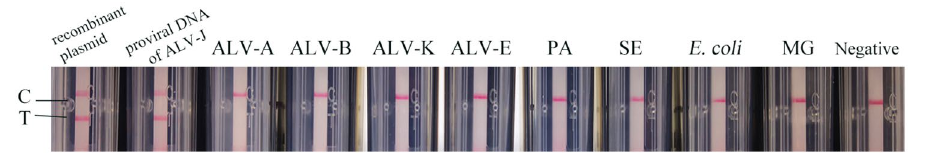
Figure 9. Analysis of the specificity of the ALV-J CPA method. PA Pseudomonas aeruginosa, SE Salmonella enteritis , MG Mycoplasma gallisepticum , C control-line, T test-line.